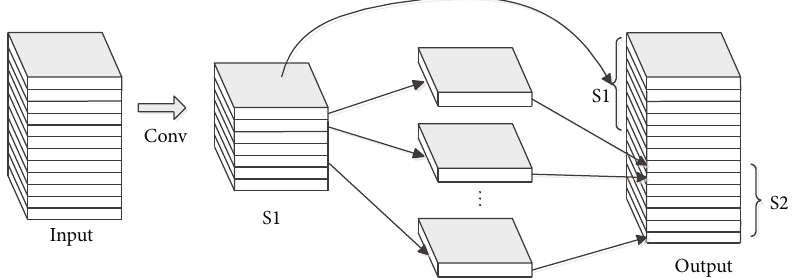
Figure 4: Depth-wise separable convolution.